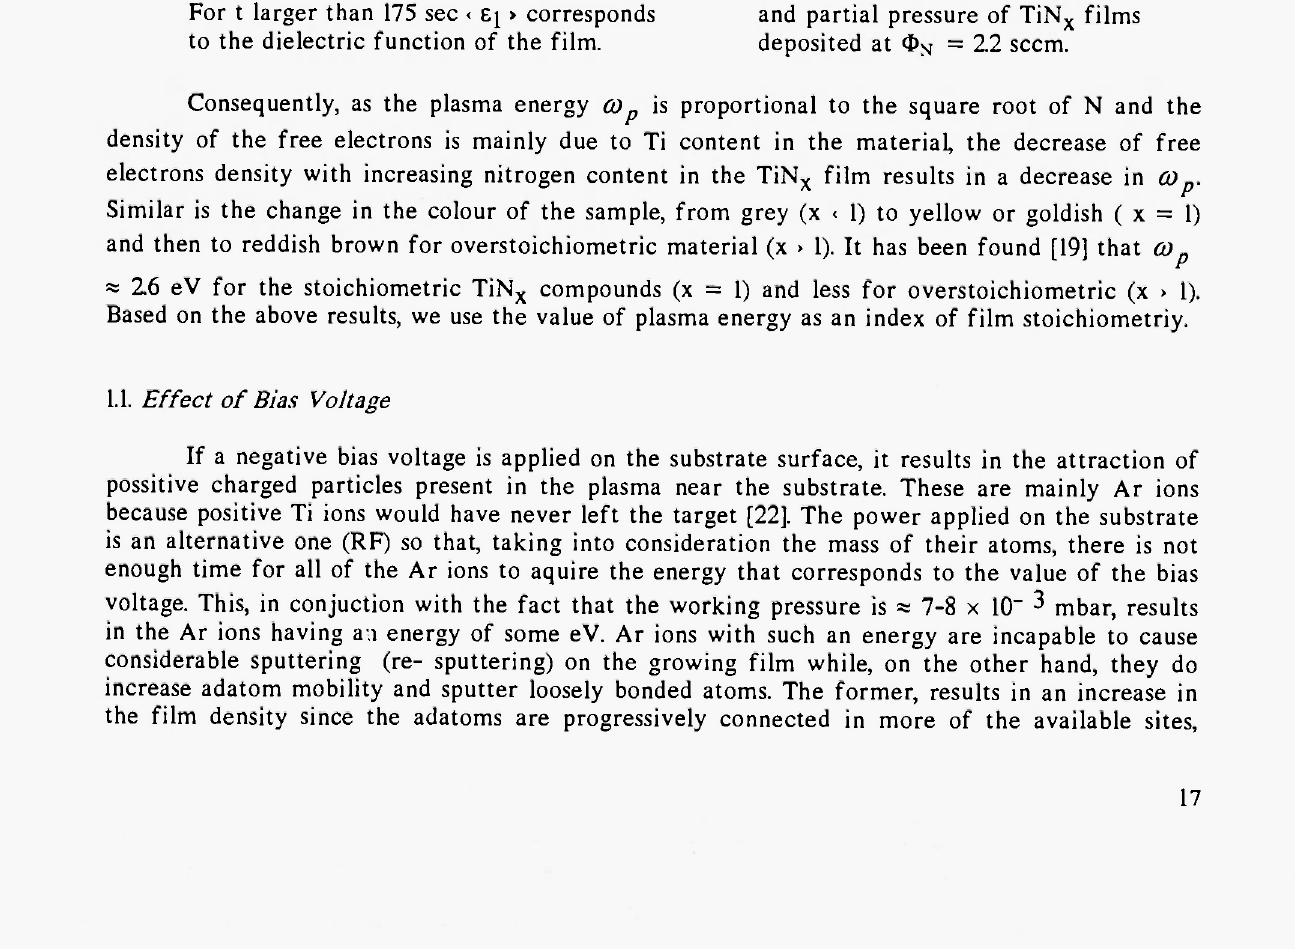
Fig.l The < Ej > of TiN sequantial layers. Fig. 2 The dependence of ωρ on Φ x For t larger than 175 sec < ε^ > corresponds and partial pressure of TiN to the dielectric function of the film. deposited at Φ